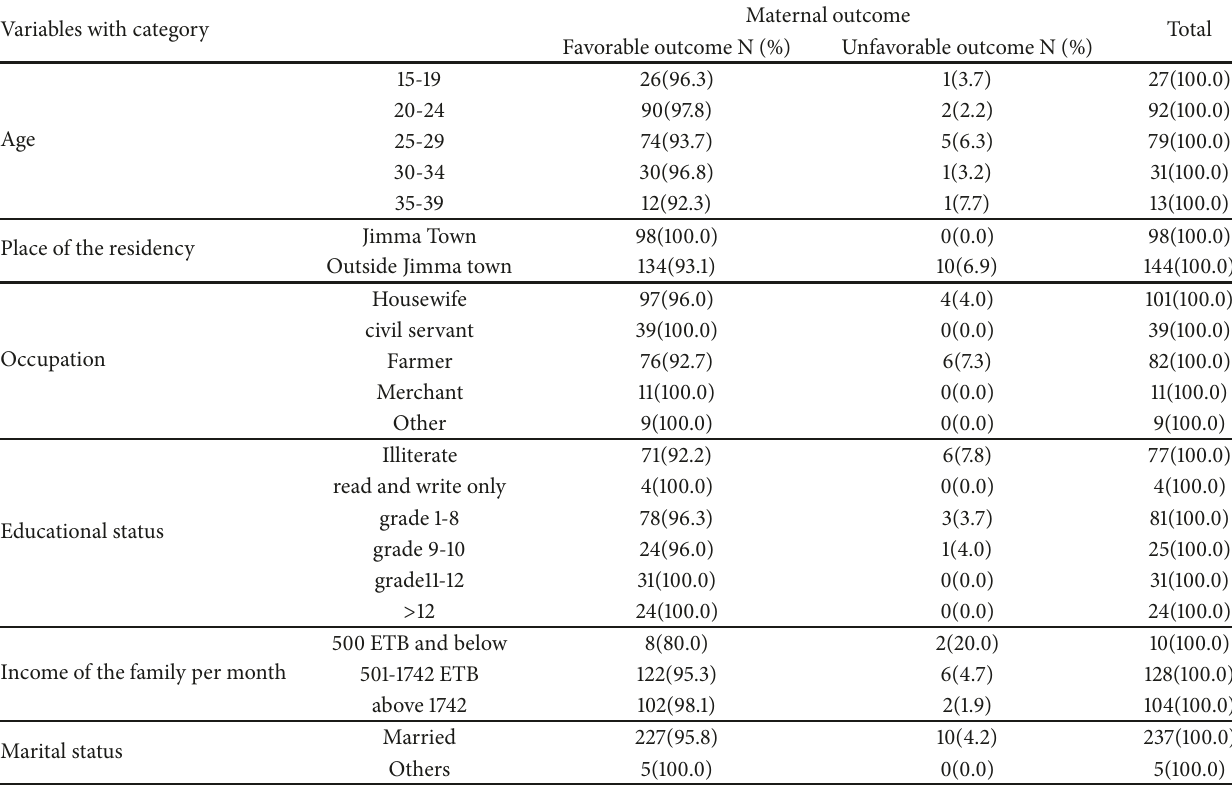
Table 5: Distribution of maternal outcome cross tabulated with sociodemographic characteristics among mothers who gave birth by OVD in JUMC December 1, 2016–May 30, 2017.